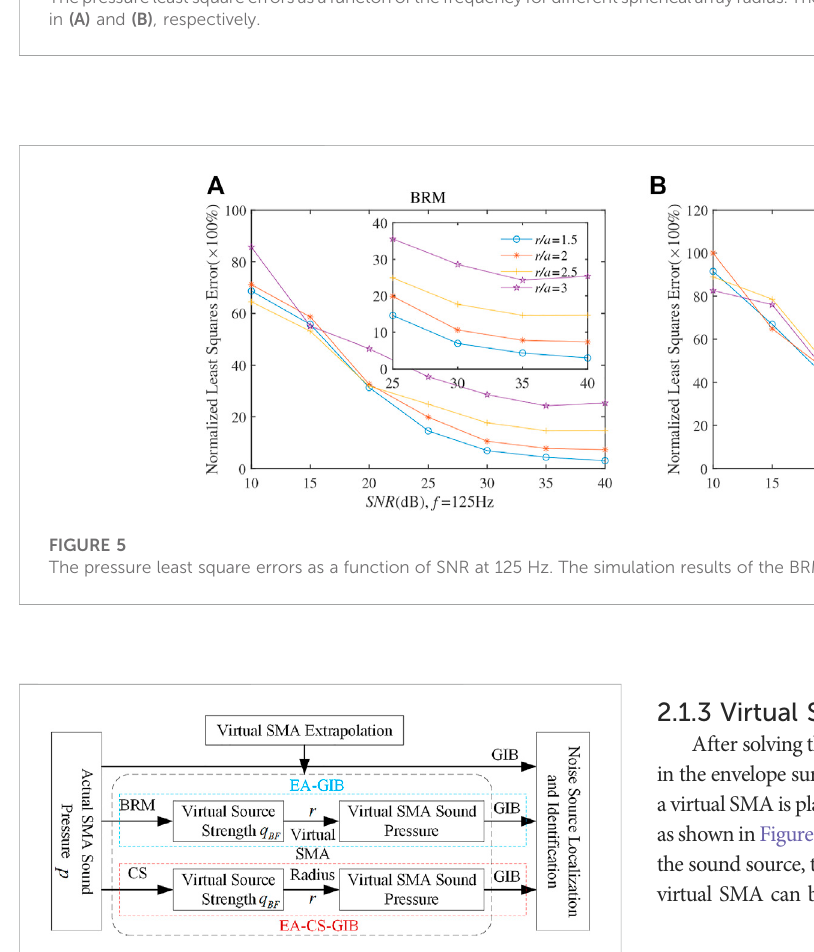
FIGURE 6 Schematic diagram of virtual SMA localization and identi fi cation.